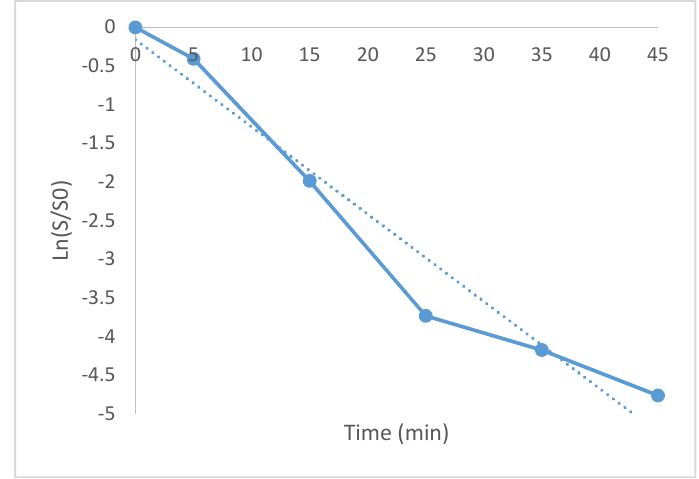
Figure 7. Graph to calculate the kinetic decay constant of Escherichia coli with 5% Ag/bovine powder. Continuous line: Experiments, dotted line: linear regression.